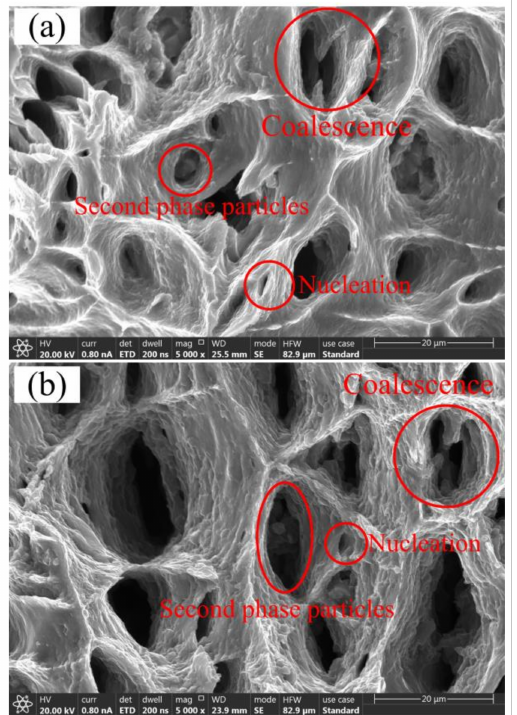
Figure 11. Fracture morphology of w = 30 (as shown in Figure 7) samples at different temperatures.